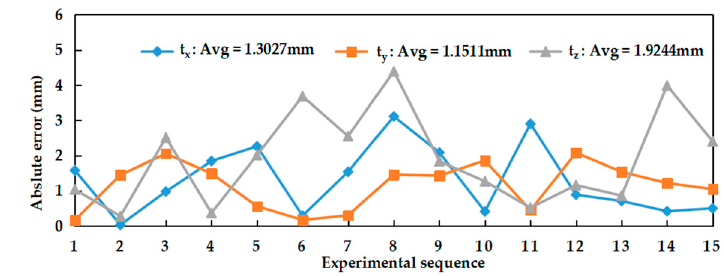
Figure 12. Absolute error of the translation vector.